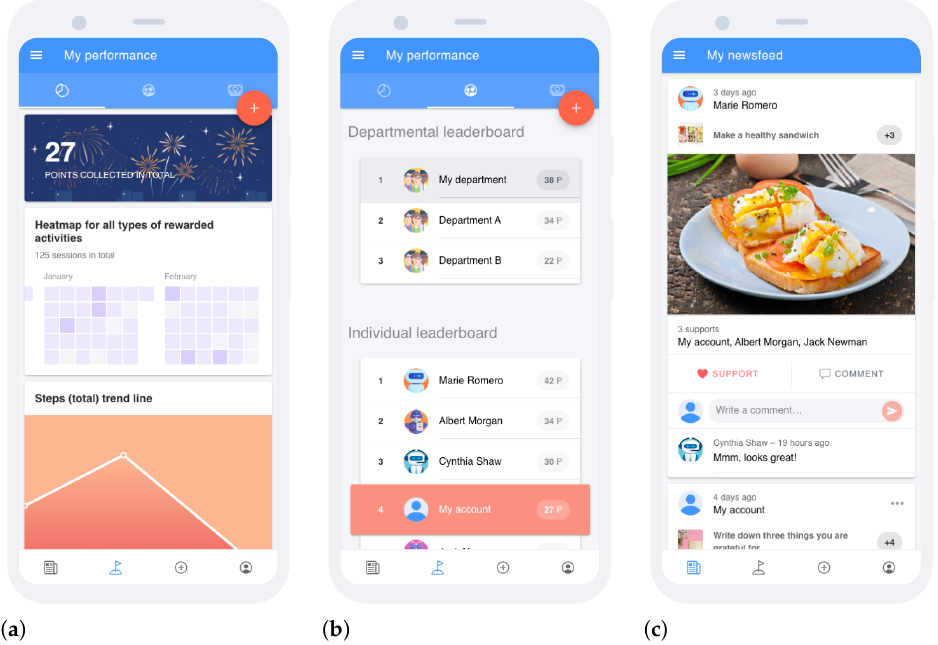
Figure 1. Overview of different performance visualizations that were available to all participants: ( a ) displays the individual dashboard, ( b ) displays the social leaderboard, and ( c ) displays the social